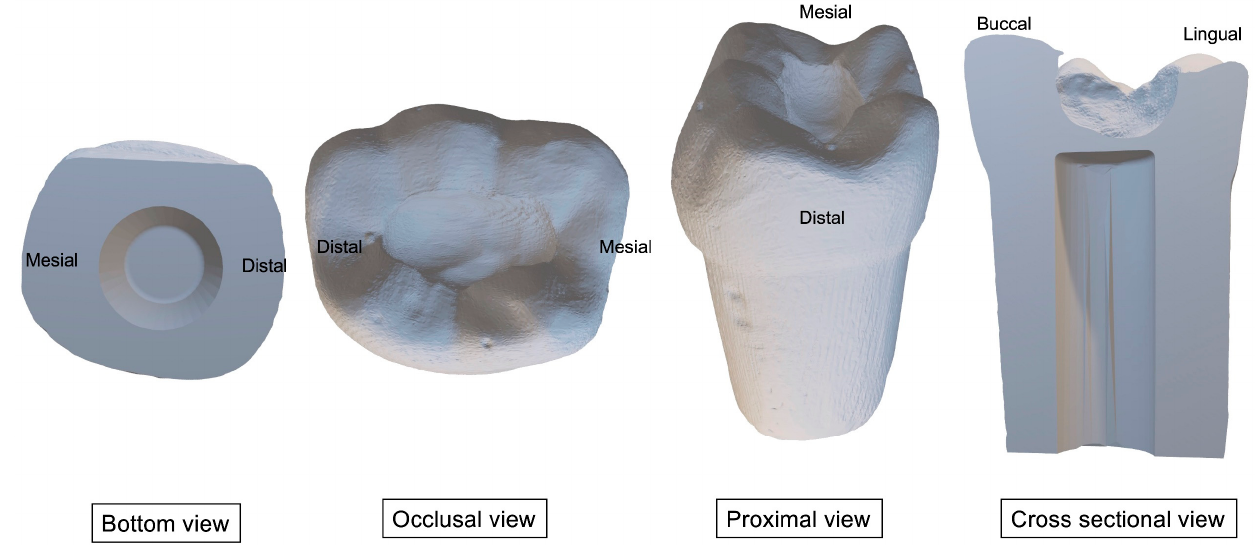
Figure 1. 3D images of the permanent lower-left first molar with the occlusal cavity.